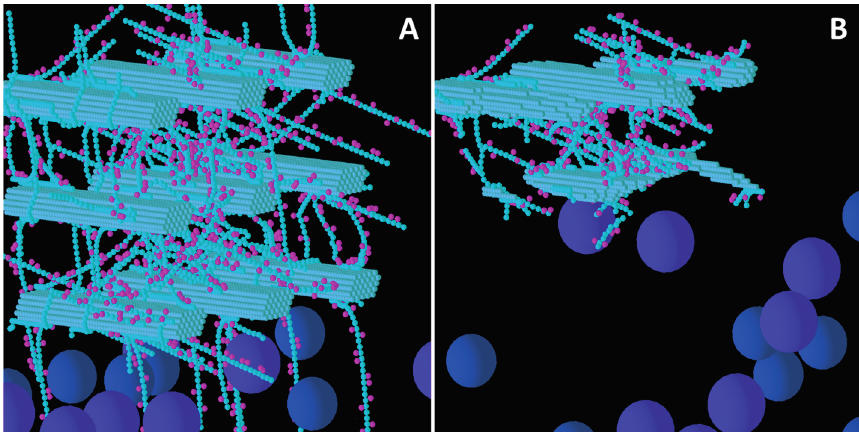
Figure 2. Initial structure of the Low xyloglucan (XG) model cell wall ( A ) and the end result of its degradation after a simulation run ( B ). Glucose and xylose are represented by the smaller spheres coloured blue and magenta, respectively. Larger spheres represent Cel51A ( purple ) and Cel9D ( blue ). Enzymes shown in pane A are in their original positions, located in the hypothetical biofilm